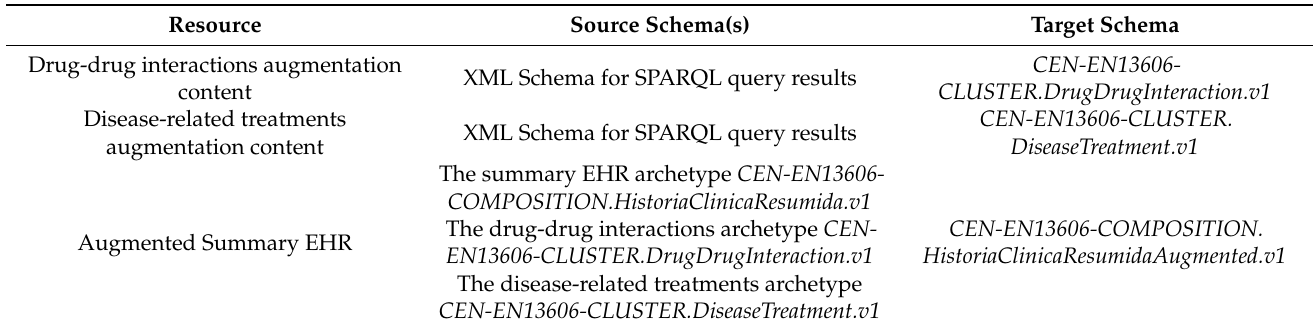
Figure 13. Archetypes’ visualization from LinkEHR. ( a ) The initial EHR archetype CEN-EN13606- COMPOSITION.HistoriaClinicaResumida.v1 . The EOIs used in this use case are highlighted. ( b ) The augmented archetype CEN-EN13606-COMPOSITION.HistoriaClinicaResumidaAugmented.v1 , which is similar to the initial EHR archetype but includes archetype slots for the augmentation archetypes. Table 4. List of mapping specifications defined to obtain the augmented summary EHR. The mappings were stated using the LinkEHR platform. For each mapping specification, LinkEHR built a XQuery script whose execution converts data instances of the source schema to data instances of the target